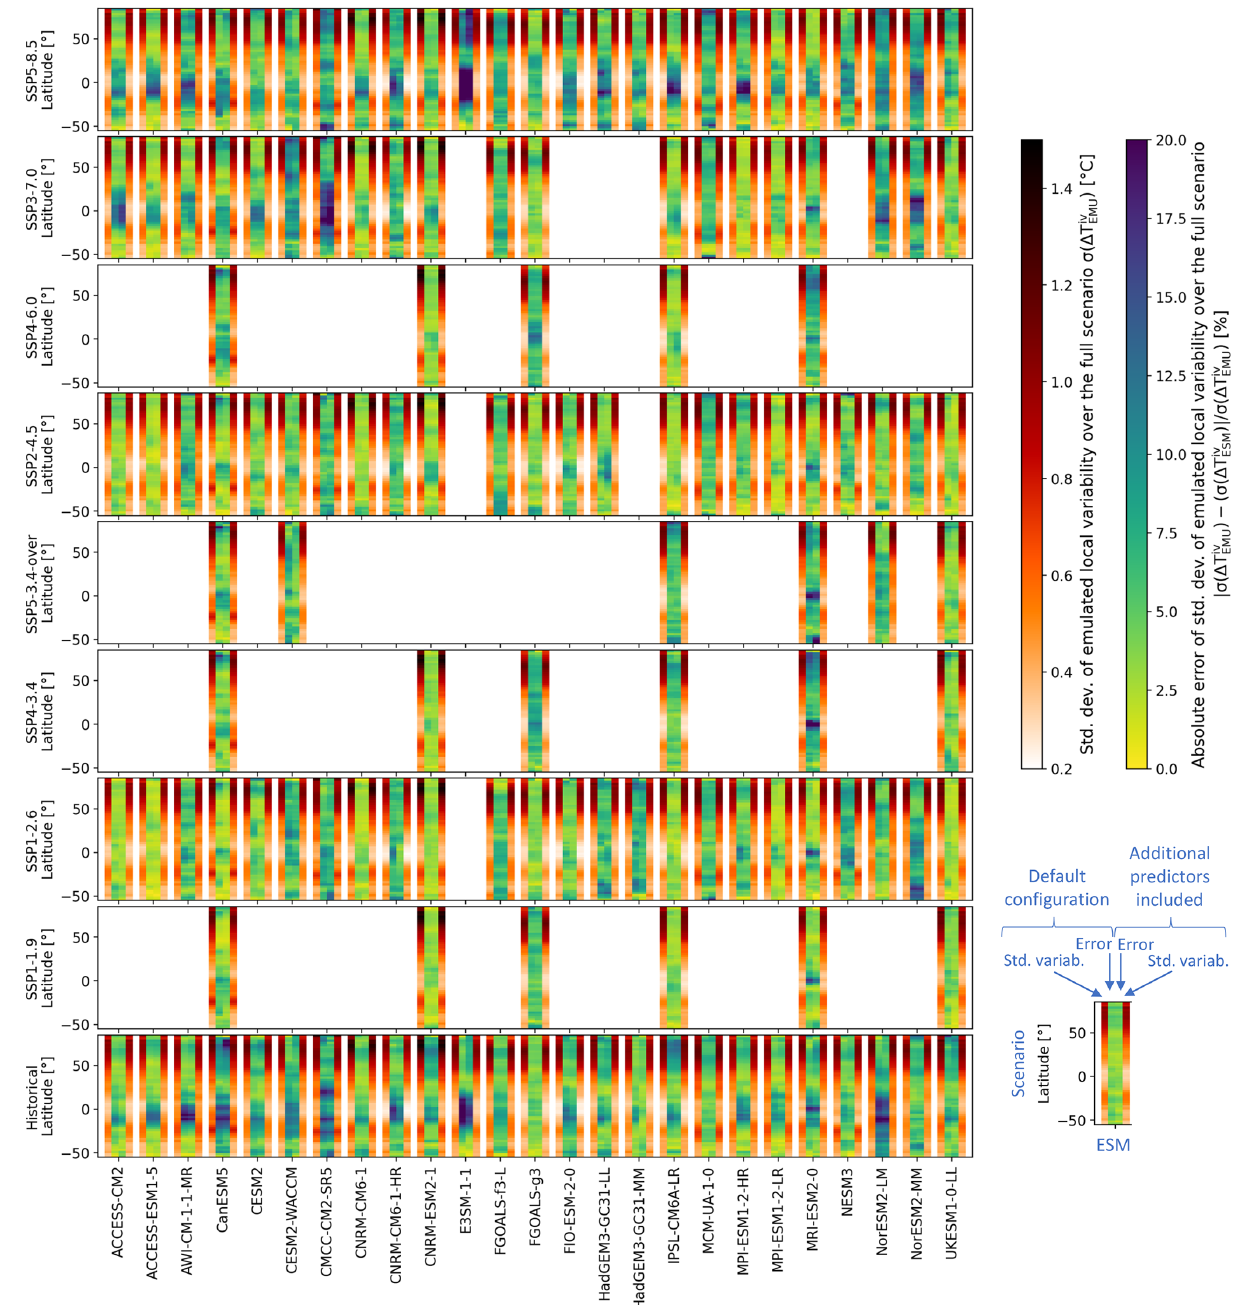
Figure 4. Latitudinally averaged grid-point-level standard deviation of emulated local variability and performance with respect to ESM simulations for both MESMER configurations over the full scenario period. The standard deviation of the emulated local variability is computed based on 600 variability emulations for each ESM. To obtain local variability from ESM simulations, the emulated local forced warming is subtracted from every ESM simulation. Subsequently, the standard deviation of these estimates of ESM simulations’ local variability is computed while employing all ESM initial-condition ensemble members available for the scenario at hand. The error shown here represents the absolute deviation between the standard deviation of the emulated variability and the standard deviation of the ESMs’ variability normalized by the standard deviation of the emulated